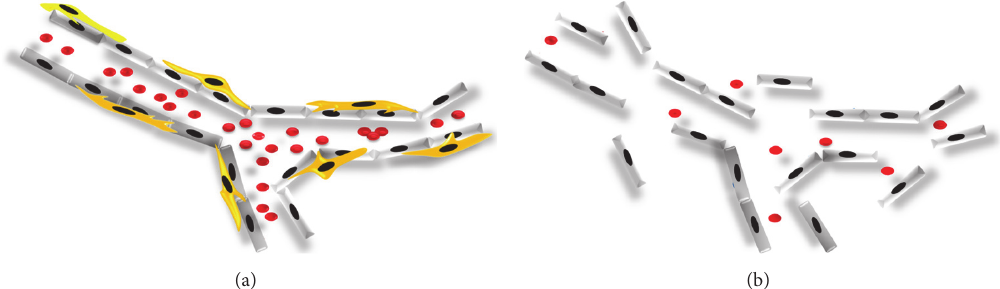
Figure 1: (a) MSC and ECFC collaborate to form stable, perfused, and functional vessels in vivo. The inner layer of the vessel is established by ECFC (grey), whereas MSC (yellow) form the outer layer of neovessel to support the stability and functionality of the vasculature. (b) Unstable vessel. In the absence of mesenchymal stem cells, the inner layer of the neovessel raptures due to the lack of pericytes which play a crucial role for maintenance of vasculature stability in